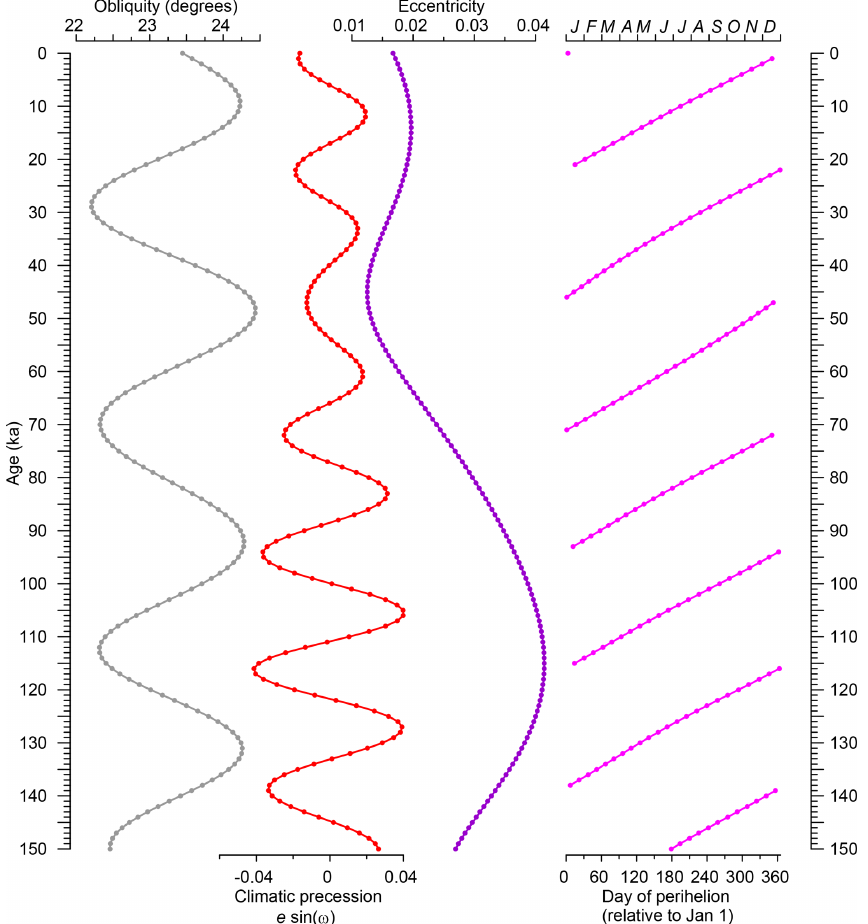
Figure 6. Orbital parameter variations at 1kyr intervals over the past 150kyr for obliquity, climatic precession, eccentricity, and day of perihelion (relative to 1 January). Climatic precession is calculated as e · sin ω , where e is eccentricity and ω is the longitude of perihelion measured from the vernal